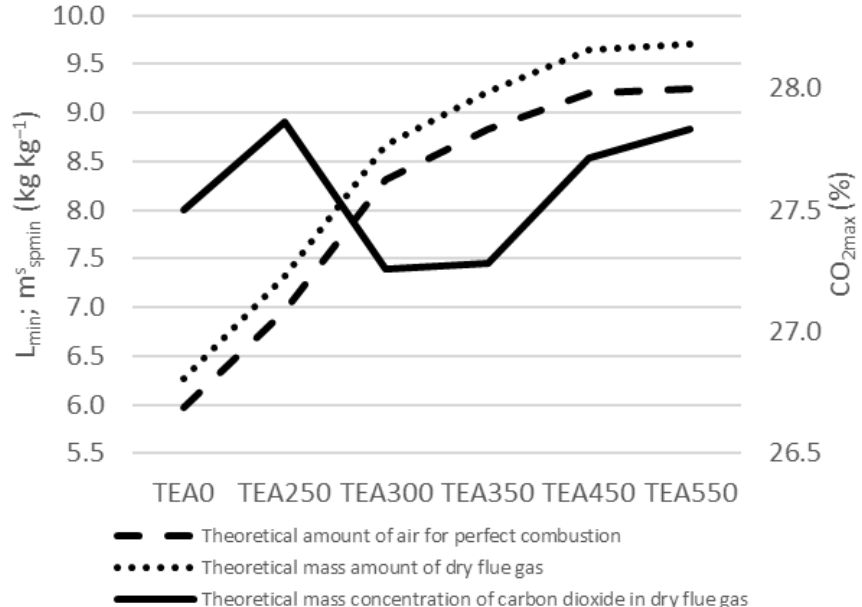
Figure 8. Mass combustion of tea waste. The share of CO 2 mass concentration in dry flue gas is at the highest level for TEA250 and then decreases for TEA300 and TEA350. CO 2 mass concentration in dry flue gas is again at a higher level for TEA450 and TEA550. The share varies among 27.2% and 27.9% of dry flue gas: [ CO 2 max ( % wt . )] . Very similar numbers are also in Figure 9, showing the theoretical volumetric combustion.